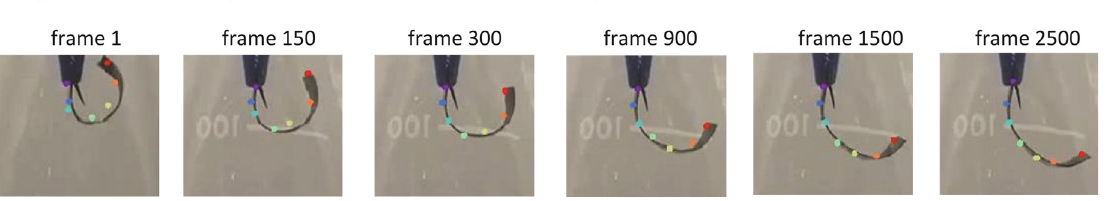
Fig 4. Tracking with deep neural networks. DNN-based tool DeepLabCut produced tracking well correlated with the manually obtained ground truth. The colored dots are the key point location predicted by the tool. The predicted key points had greater errors in the initial frames of the video compared to the later frames.